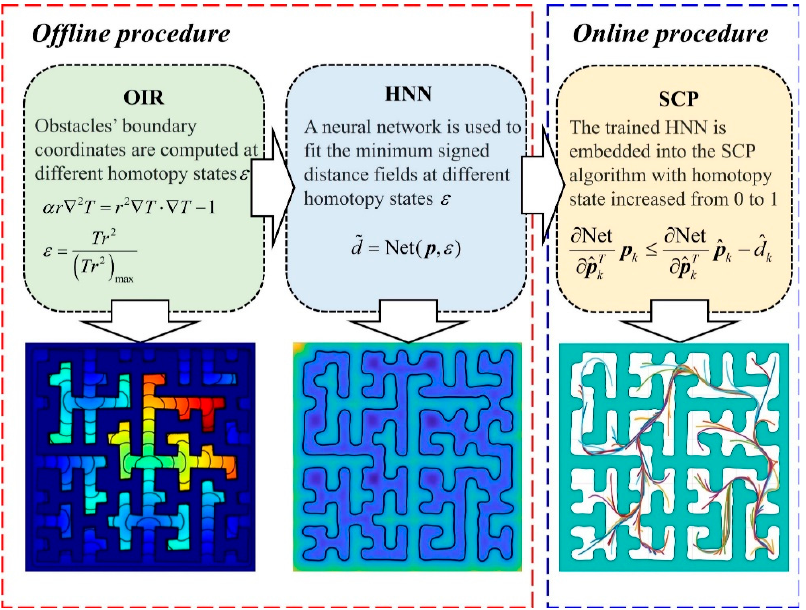
Figure 2. Schematic diagram of proposed HNSCP